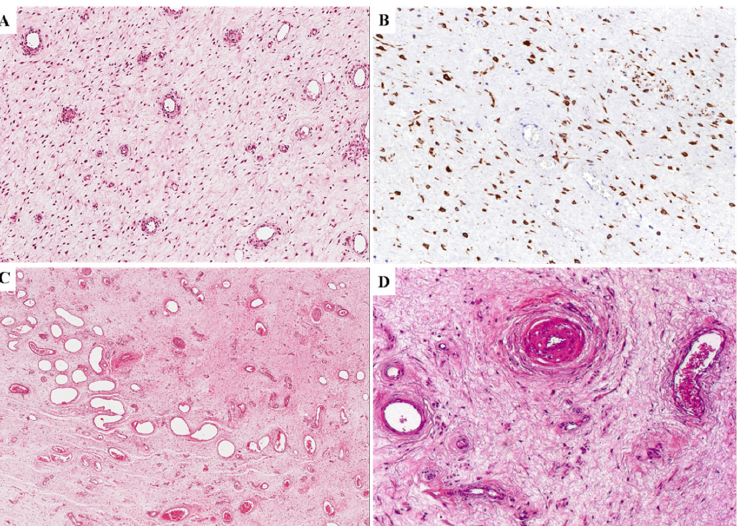
Figure 2. Classic-type DAM . ( A ) Hypocellular tumor composed of bland-looking small-sized spin- dled to stellate cells set haphazardly in an abundant myxo-edematous stroma with numerous capillary-like blood vessels. ( B ) Neoplastic cells of classic-type DAM are diffusely and strongly stained with desmin. ( C ) The vascular component ranges from capillary-like to medium/large-sized blood vessels. ( D ) The larger vessels occasionally contain a prominent smooth muscle